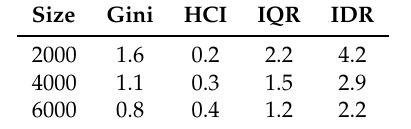
Table 4. Relative standard deviation (%) of each parameter without applying PSA. Size